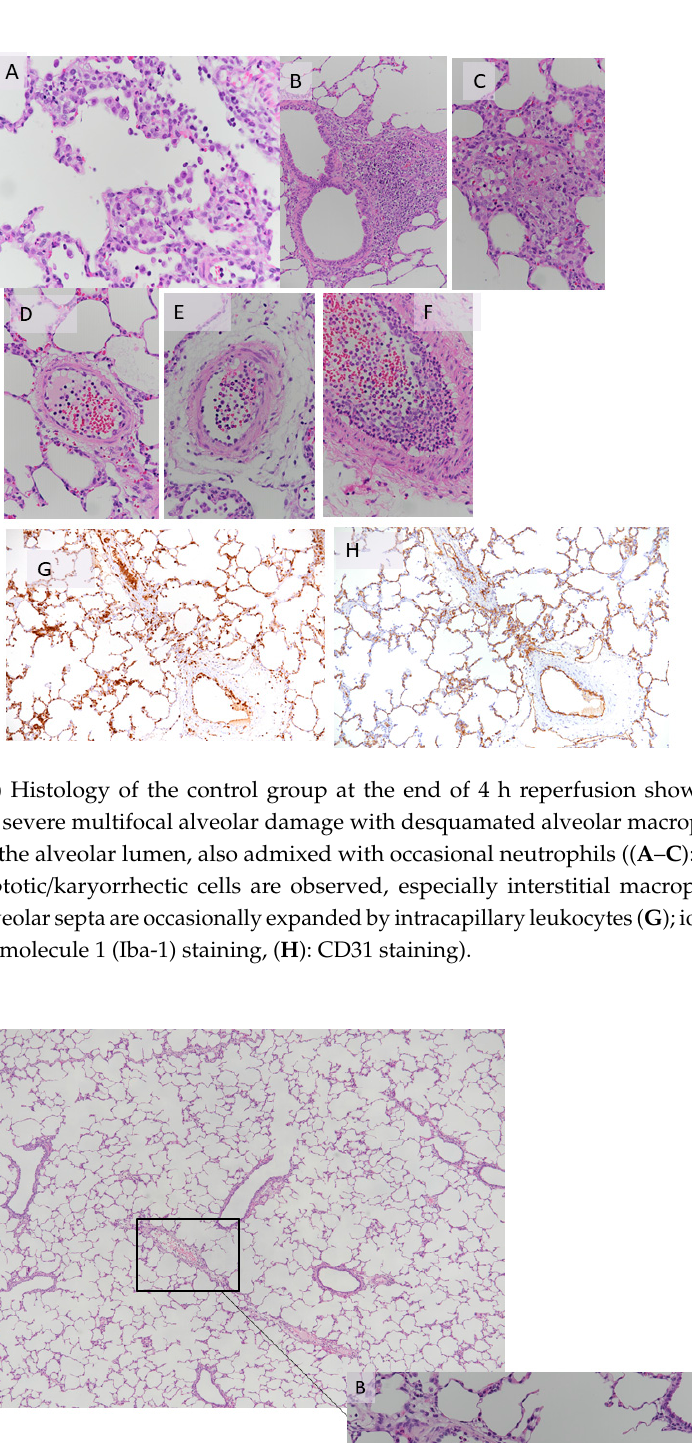
12 of 22 Table 4. Histologic score for inflammatory process observed after lung transplantation. Group NL in Vessels NL Emigration NL in Alveoli Total Score Average Score CONT